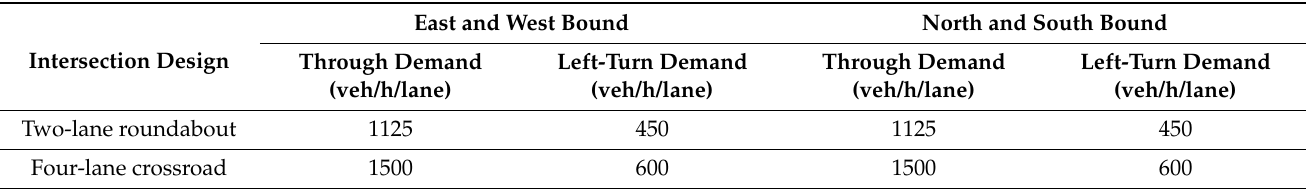
Table 2. Demand settings for performance